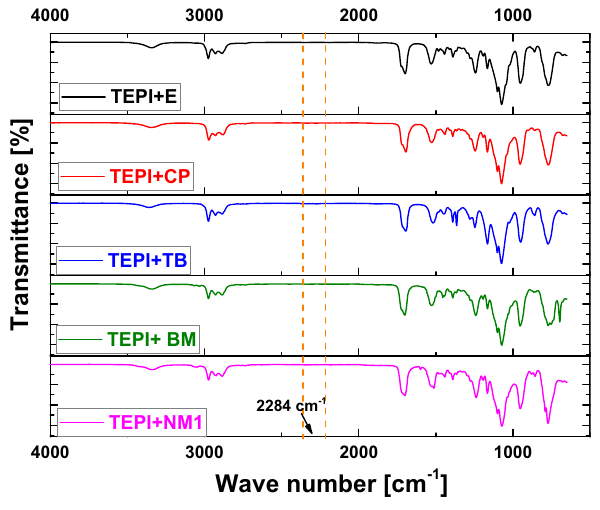
Figure 6: FTIR spectra of all synthesized silanes.